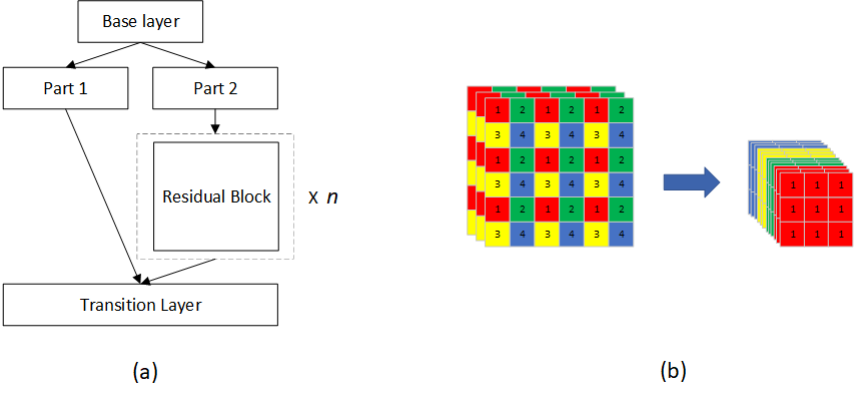
Figure 6. CSPNet and Focus network. ( a ) CSPNet: CSPNet is able to achieve richer gradient combinations while reducing the amount of computation. ( b ) Focus network: Using the focus layer can reduce parameter calculation and reduce the memory usage of